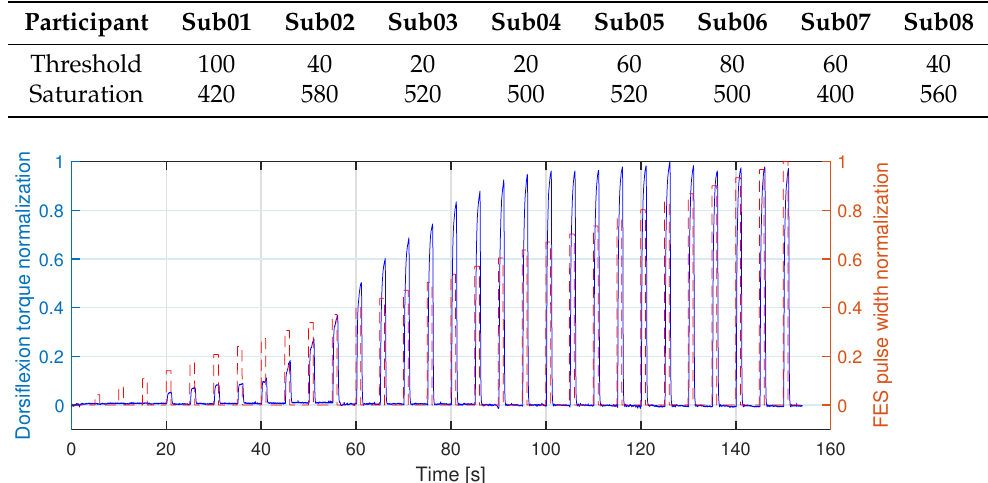
Figure 3. The normalization of FES pulse width that applied on the TA muscle and the normalization of ankle dorsiflexion torque measurements on Participant Sub01 during the first